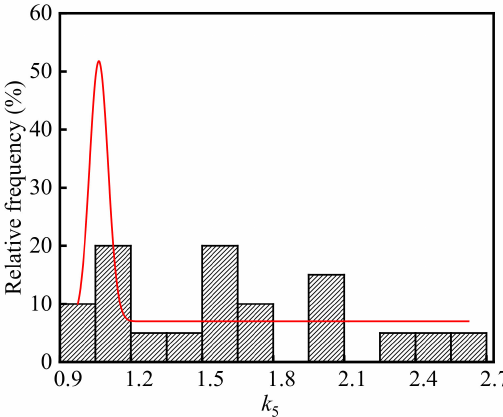
Figure 10. Frequency distribution histogram of k 5